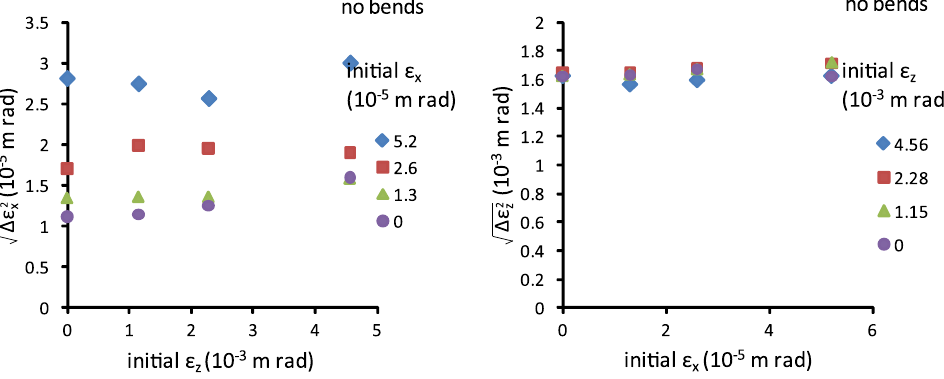
FIG. 9. Square root of (cid:1) (cid:1) 2